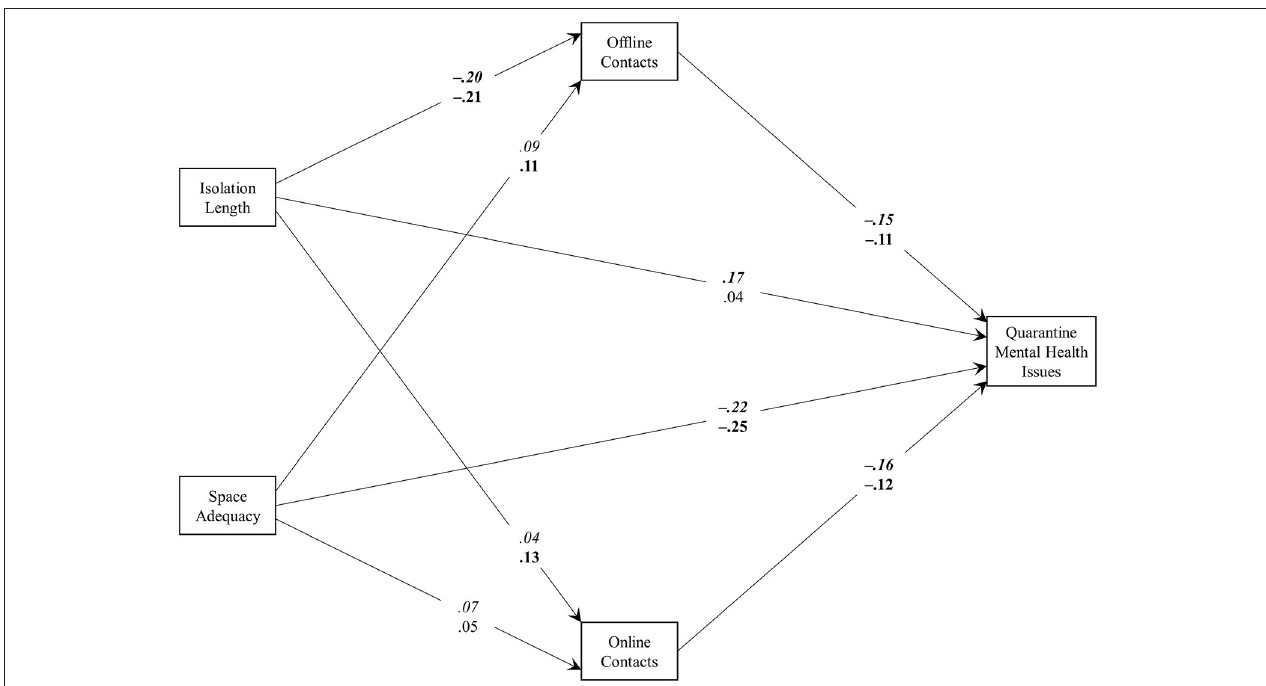
FIGURE 1 | The results of the multi-group path analysis model. Parameters for the low-contagion and high-contagion subsamples are reported in italics and plain text, respectively. Parameters in bold are significant at level p <